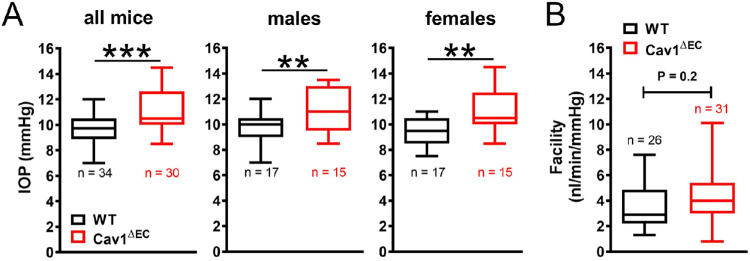
IOP and outflow facility in Cav1ΔEC mice. (A) The IOP was significantly increased in Cav1ΔEC mice compared with WT mice, as measured by rebound tonometry (***P = 0.0001, two-tailed unpaired t test analysis, n = 30–34 mice for each group). IOP was also significantly increased in both male and female Cav1ΔEC mice compared with WT mice (**P = 0.0075, two-tailed unpaired t test analysis, n = 15–17 mice for each group). (B) Outflow facility not significantly different between Cav1ΔEC mice and WT mice (P = 0.2, two-tailed unpaired t test analysis, n = 26–31 mice for each group).